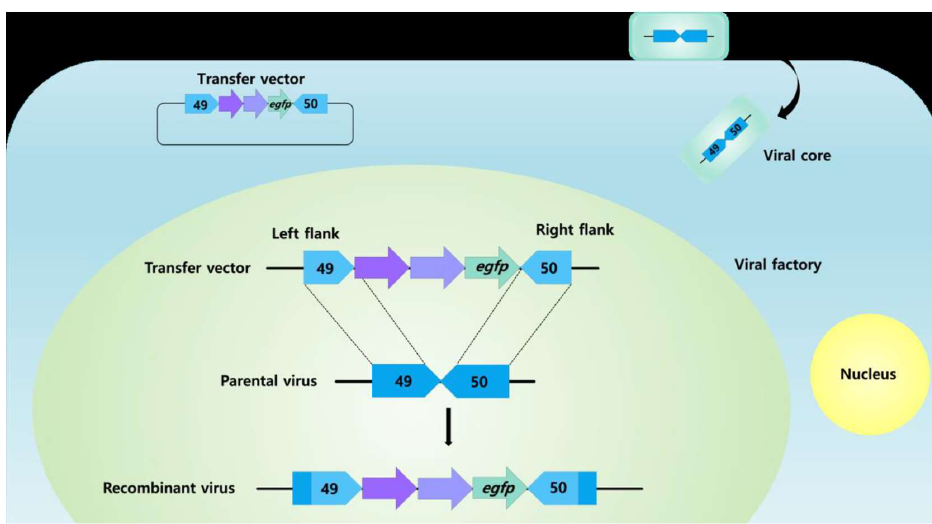
Figure 6. Schematic diagram of the generation of a recombinant poxvirus by homologous recombination of parental virus and a transfer vector. The plasmid encoding the transfer vector contains two antigen genes (purple arrows), an enhanced green fluorescent protein gene (egfp) as a marker gene (green arrow) as well as left and right flanks (49 and 50 flanks, respectively; blue arrows). Overall, 49, left flank of the transfer vector, ±300 bp of the 3′ end of 049 ORF of the LSDV genome; 50, right flank of the transfer vector, ±300 bp of the 3′ end of 050 ORF of the LSDV genome. All genes expressed by poxviruses are under the control of poxvirus promoters [99] (From student thesis where I am the